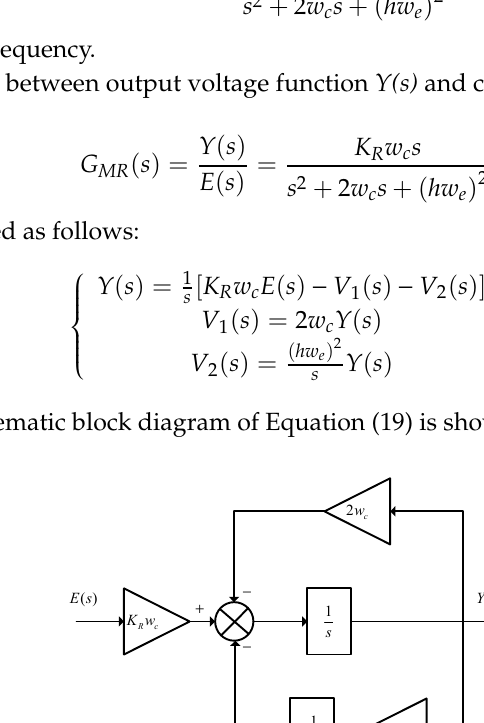
-200 Figure 8. Bode diagram for different values of w c when K R is constant. -60 -40 -90-4504590 w c =2 w c =4 w c =6